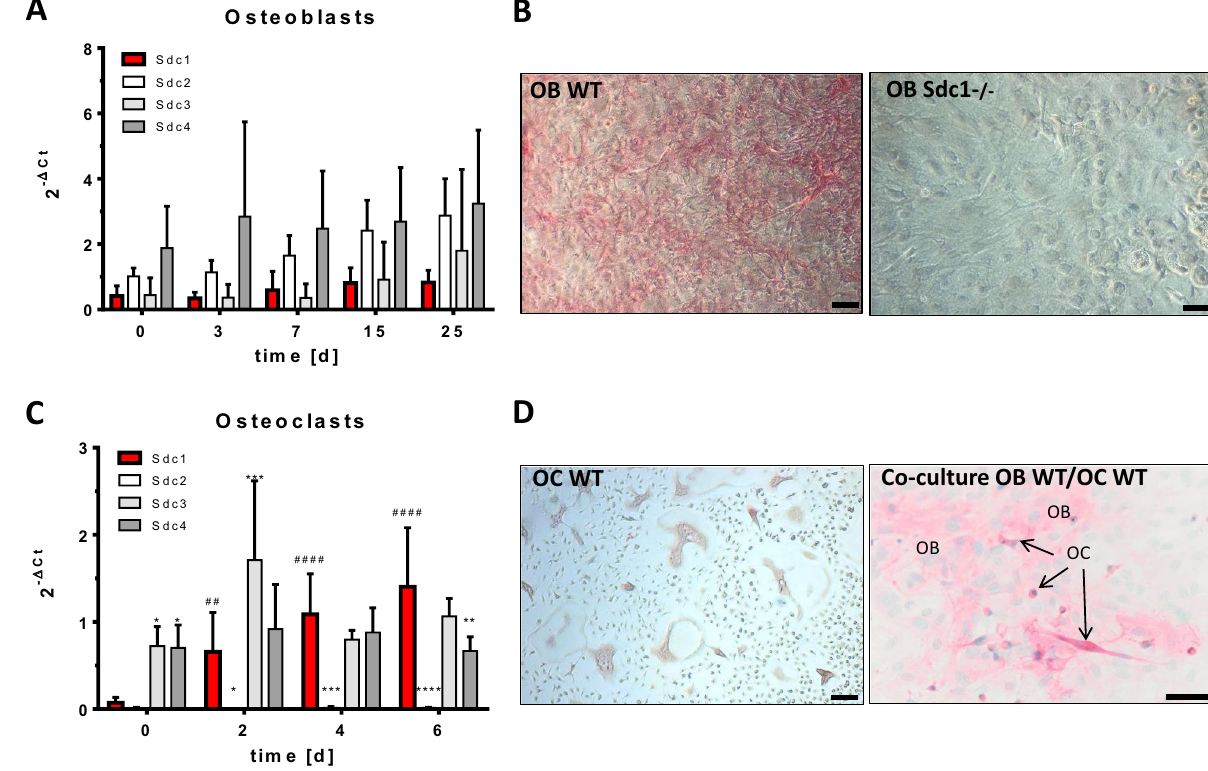
Figure 1. Expression of Syndecans in osteoblasts and osteoclasts during differentiation in vitro. Primary osteoblast precursors were isolated from calvariae of newborn mice and seeded in DM-Medium (see Table 1). Osteoclast precursor cells were isolated from bone marrow of long bones of 4–6 week old mice and seeded in DM-Medium supplemented with rmM-CSF and rmRANKL. Co-cultures of osteoblasts and osteoclasts were performed in presence of 1,25(OH) 2 D 3 and PGE2 (DM + , see Table 1). ( A,C ) mRNA expression of Syndecan-1–4 (Syndecan-1 in red) were analysed using quantitative real time PCR (primers see Table 2) normalized to HPRT (ΔCT method). ( B,D ) Protein expression of Syndecan-1 in the cells (after 7 days of culture) was detected using a polyclonal antibody against Syndecan-1 (in red) on the cell layer of osteoblasts (OB) in ( A ), osteoclasts (OC) in ( D ) and co-culture of OB (WT) and OC (WT) in ( E ). Scale bar: 50 µm. Experiments were performed in independent triplicates ( A , C ). Data are displayed as mean ± SD. ( A , C ) 2way ANOVA with Dunnett´s multiple comparison test * indicate expression of Syndecan-1 (red) compared to other Syndecans at each time point, # indicate expression of Syndecan-1 compared to day 0, */ # p < 0.05, **/ ## p < 0.01, ***/ ### p < 0.001, ****/ #### p <